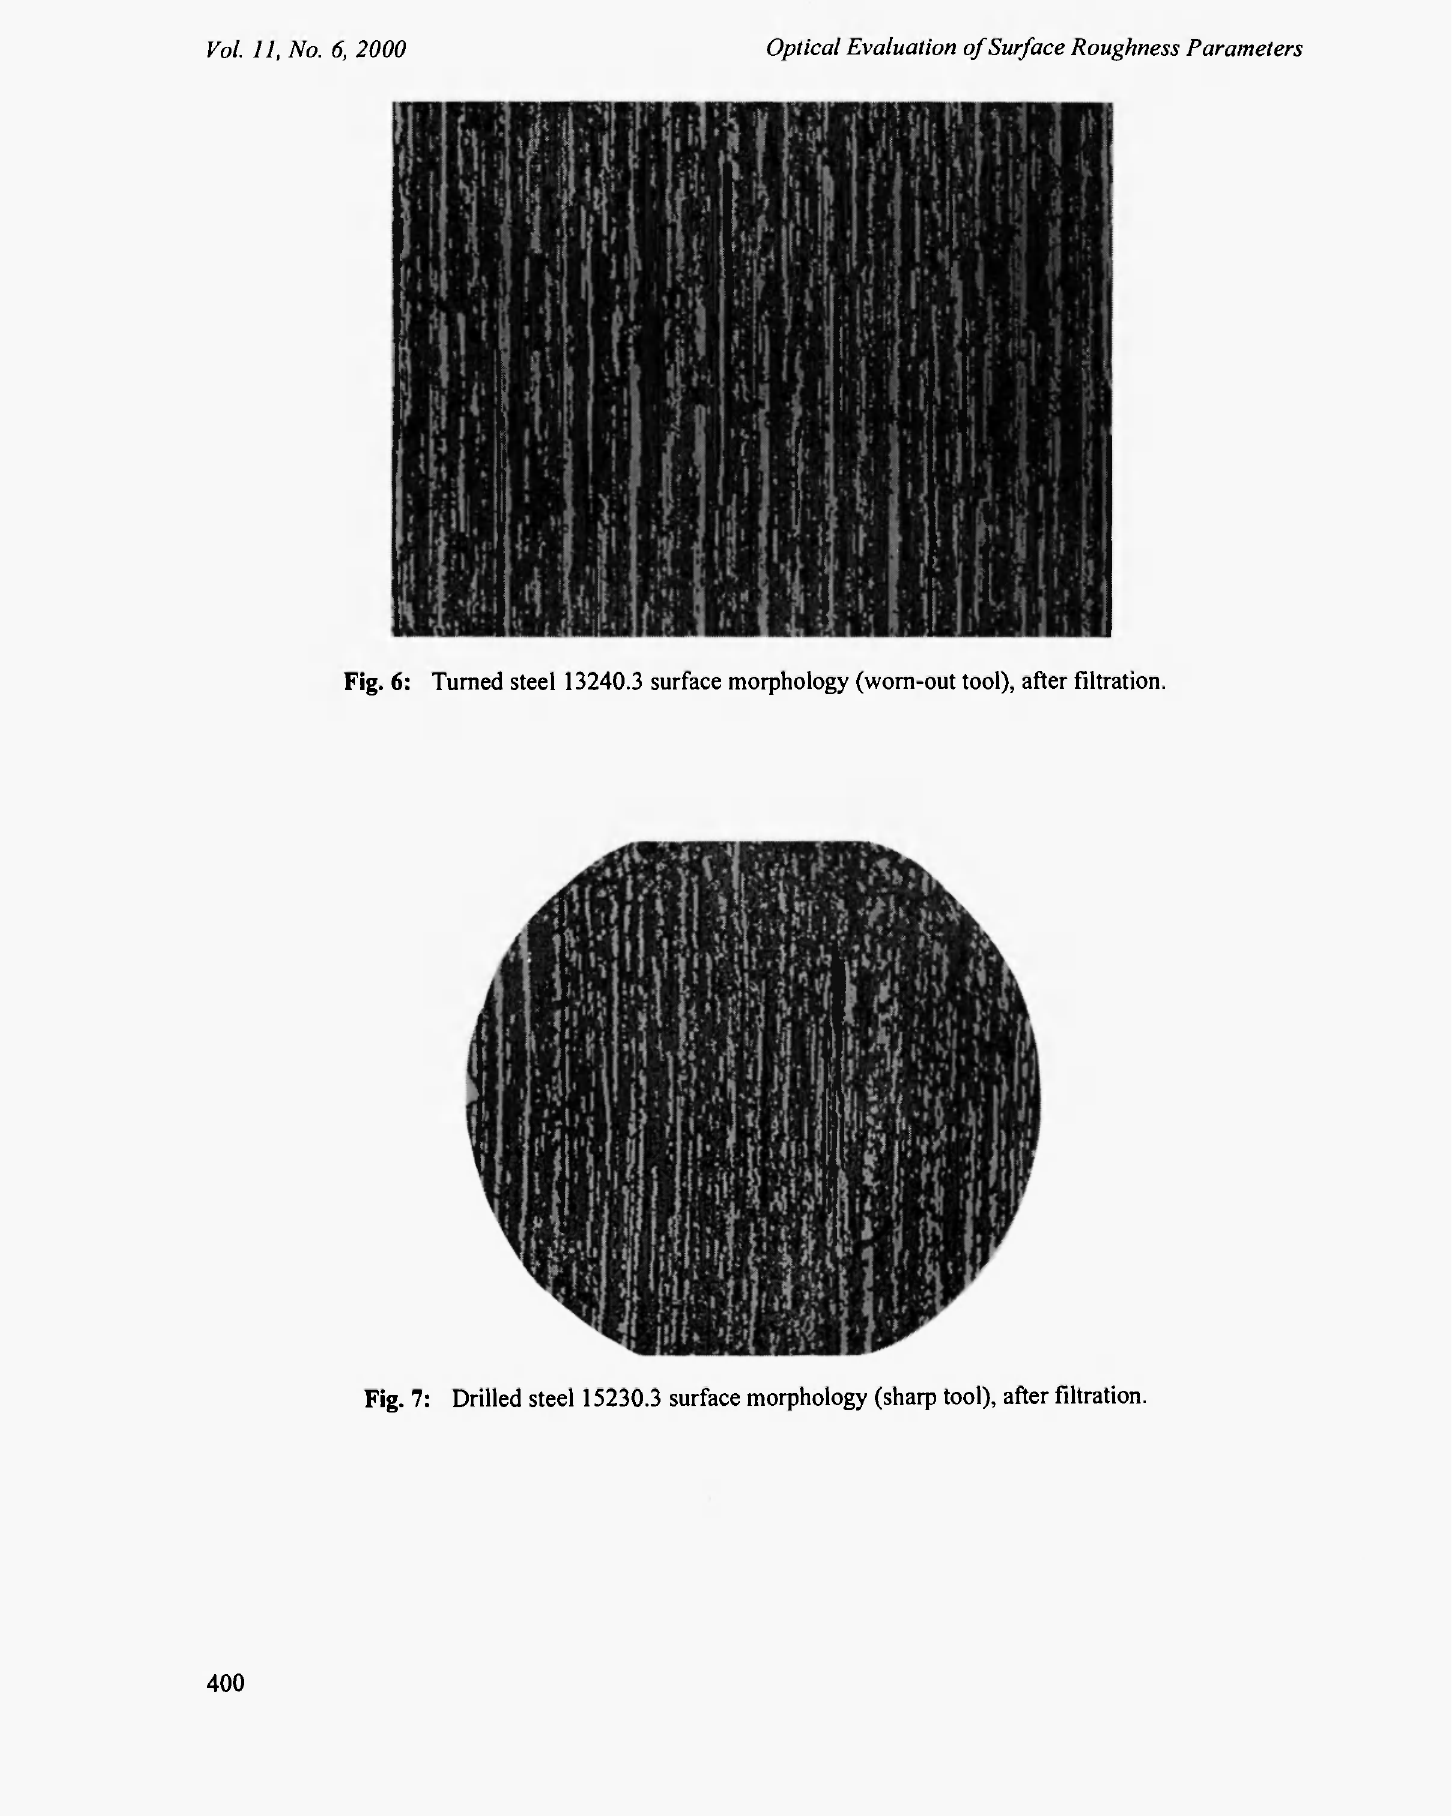
Fig. 6: Turned steel 13240.3 surface morphology (worn-out tool), after filtration.